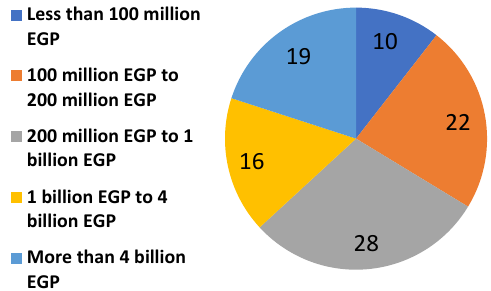
Figure 4. Yearly budget for the participants’ companies. The sample size-based standard formula is indicated in Equation